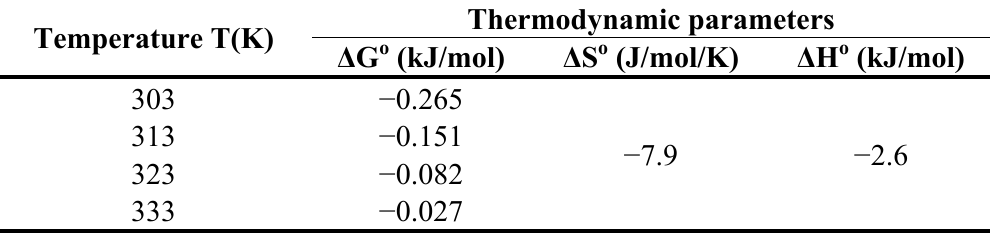
Table 4. Thermodynamic parameters for adsorption of Cd(II) onto maleic acid-treated Tamrix articulata wastes.